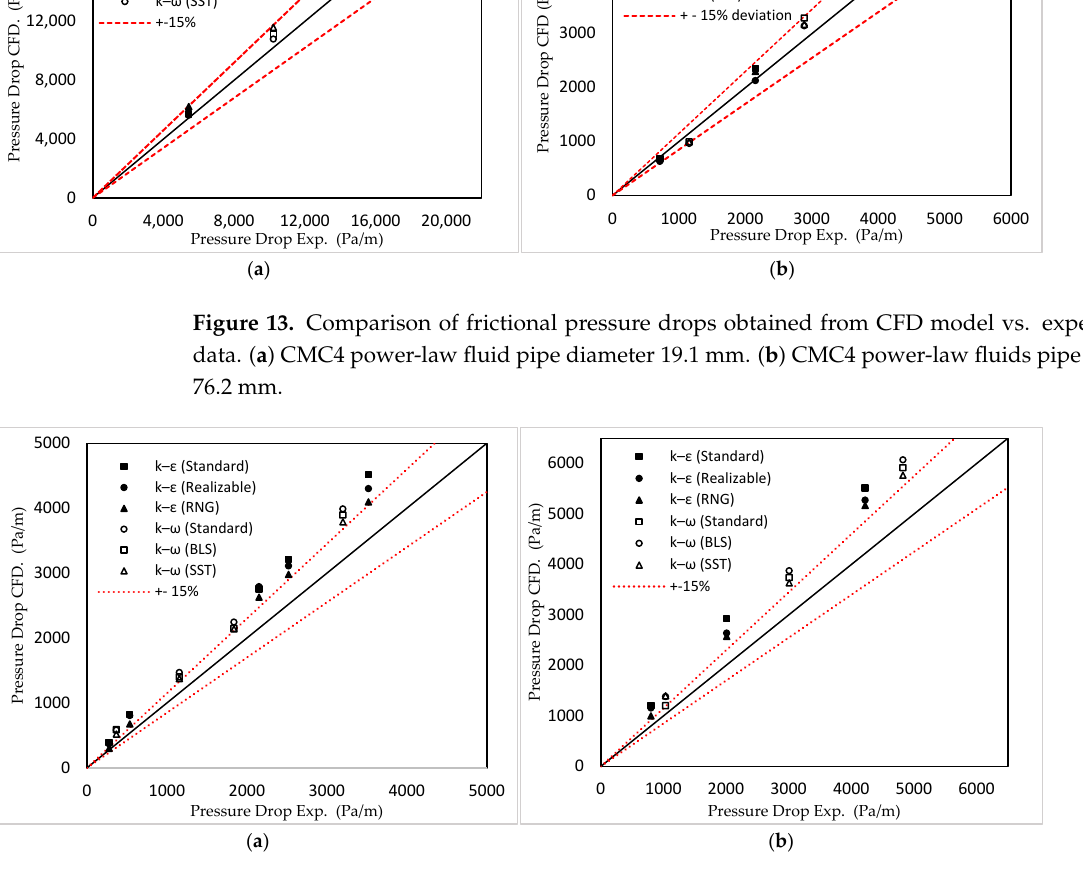
( b ) Figure 15. Comparison of pressure drop between experimental data and simulation results for standard and modi fi ed Herschel-Bulkley viscosity models: (a) BXG2 fl uid in pipe diameter 19.1 mm, (b) BXG4 fl uid in pipe diameter 76.2 mm. The Papanastasiou-modi fi ed Herschel–Bulkley viscosity equation is not available in the library of CFD codes in ANSYS Fluent 19. A turbulence model was implemented using user-de fi ned functions (UDFs). Papanastasiou’s modi fi ed viscosity equation was applied in the current CFD study. This modi fi ed viscosity function was shown to be numerically stabilized and devoid of discontinuity at a vanishing shear rate. Figure 15 shows a com- parison between experimental data and measured CFD data for di ff erent yield stress val- ues at the same pipe diameter. Figure 15a depicts a comparison between the experimental